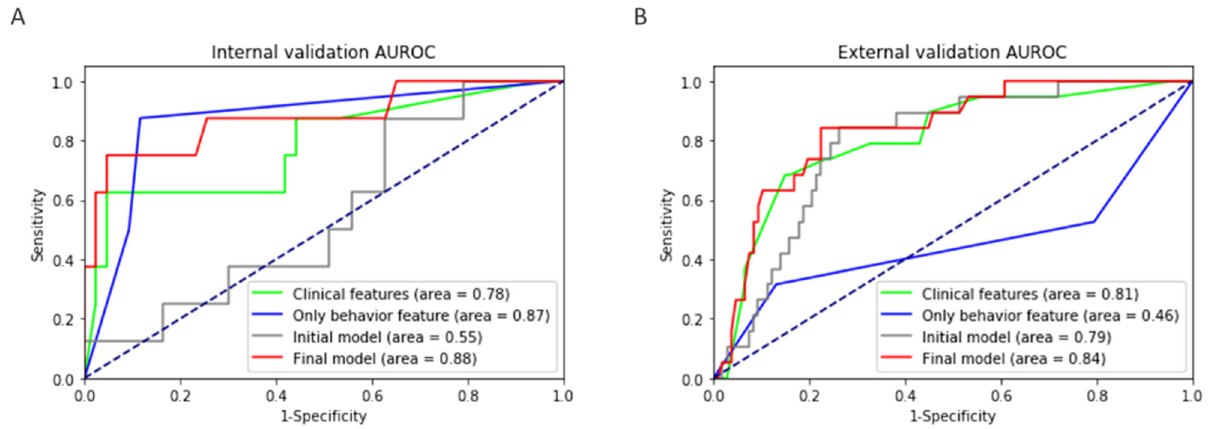
Figure 2. Comparison of four different feature combinations. The ( A ) internal and ( B ) external validation area under the